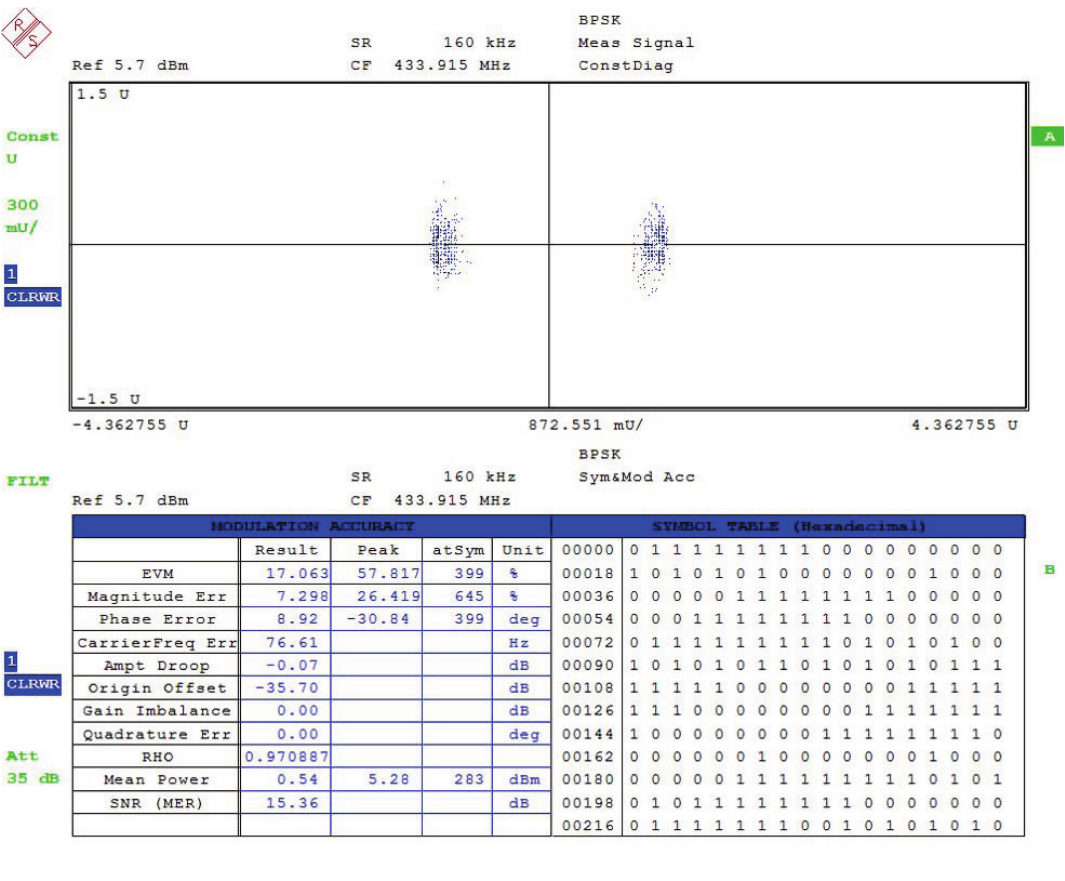
Figure 13. The measured 160 kbps binary phase-shift keying (BPSK) spectrum.